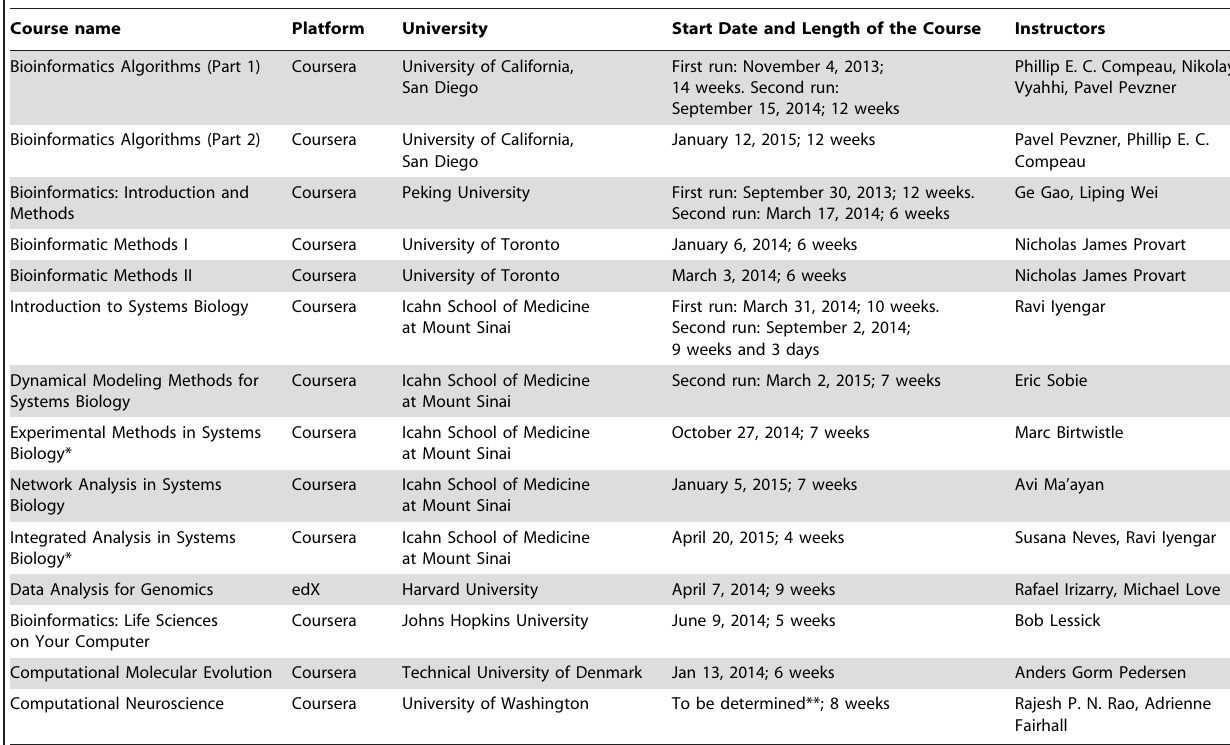
Table 3. Existing and upcoming MOOCs on bioinformatics and computational